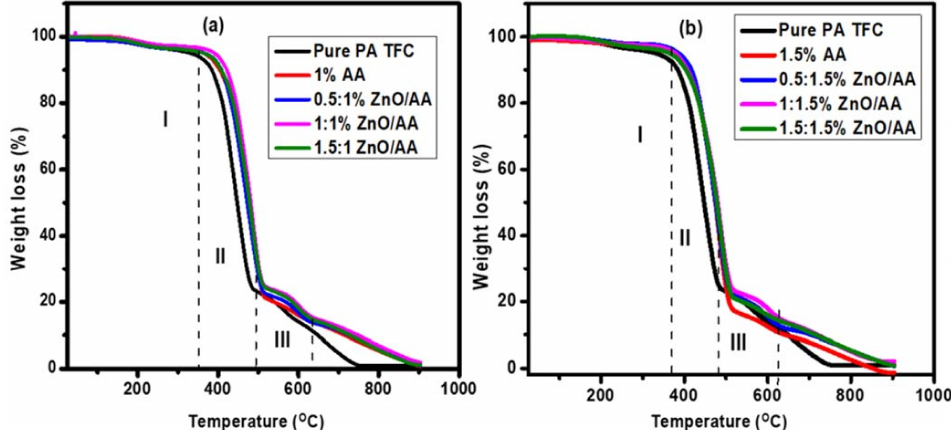
Figure 6. Thermal Gravimetric Analysis of: ( a ) unmodified membrane, and membranes modi- fied with 1.00% AA, 0.50:1.00% ZnO/AA, 1.00:1.00% ZnO/AA, and 1.50:1.00% ZnO/AA; and: ( b ) membranes modified with 1.50% AA, 0.50:1.50% ZnO/AA, 1.00:1.50% ZnO/AA, and 1.50:1.50%